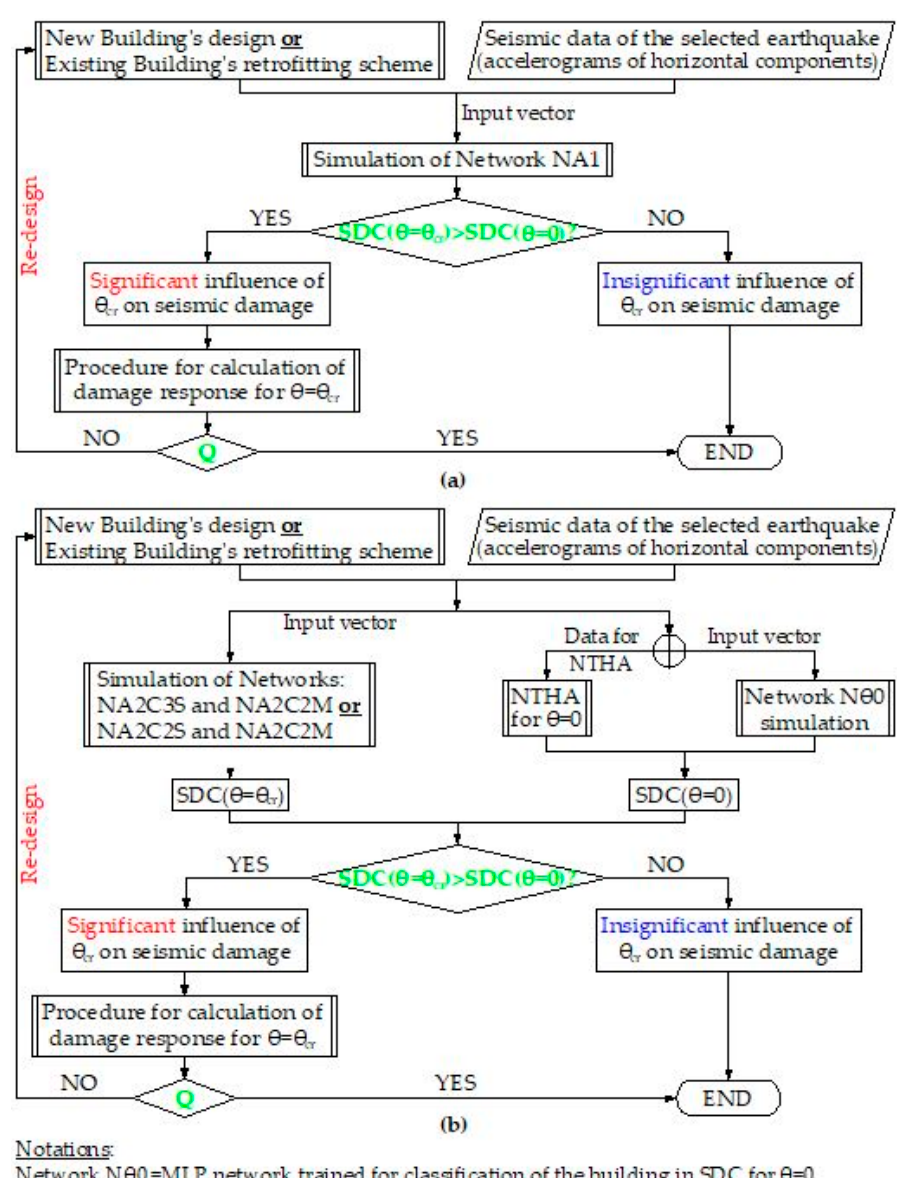
Figure 3. General flowcharts of the procedure for the study of the critical seismic angle’s influence on the SDC of RC buildings: ( a ) A1; ( b ) A2.